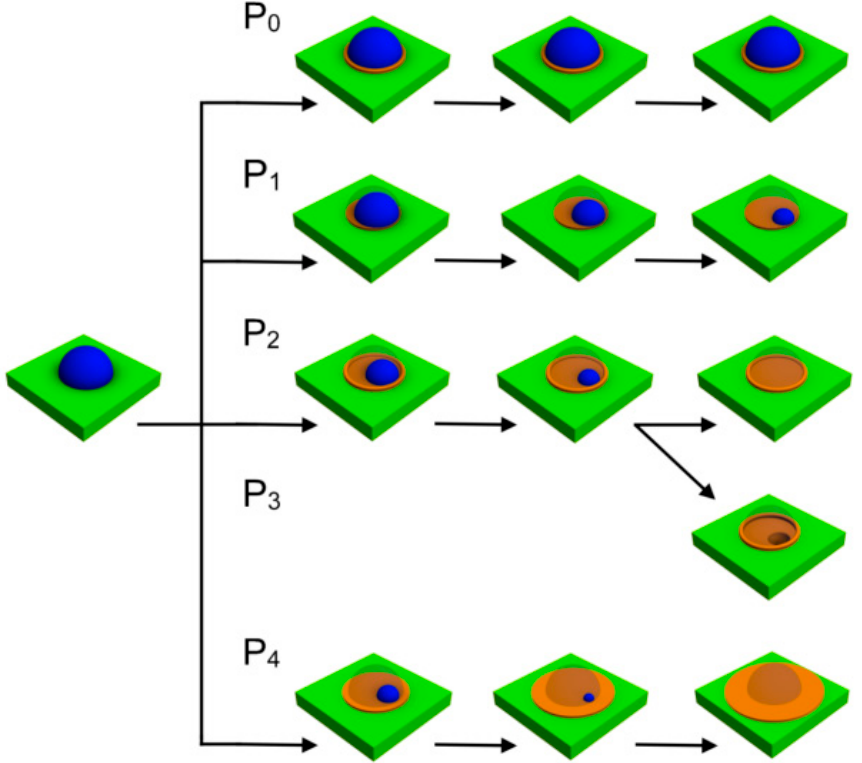
Figure 7. Schematic representation of the droplet diffusion decay under the ultra-low arsenic flux of different values where P 0 < P 1 < P 2 < P 3 < P 4 .